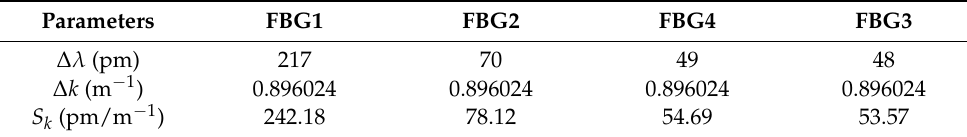
Table 9. Sensitivity of the three kinds of FBG sensors.